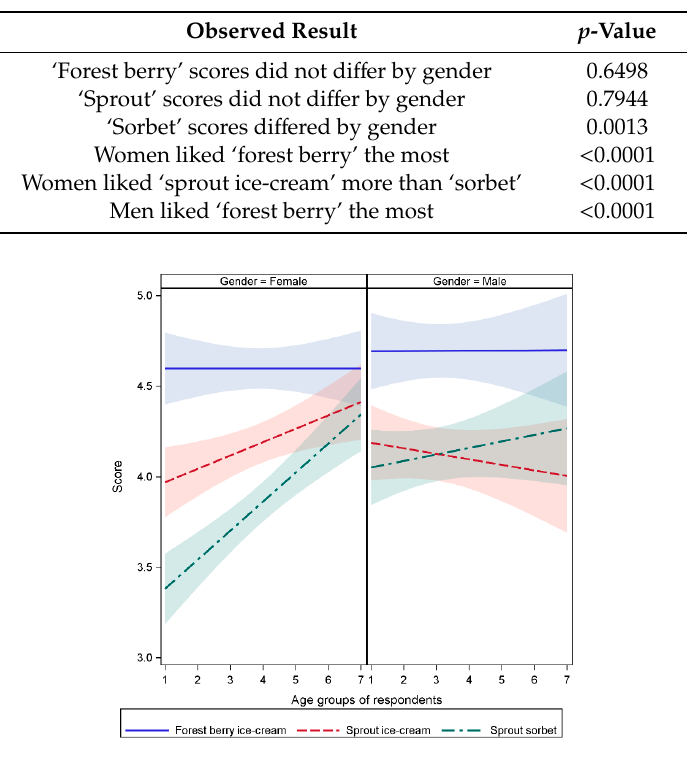
Figure 7. Di ff erences of sensory evaluation scores between gender and age groups of respondents. The evaluated products were cream-based ice-creams with forest berries (blue lines) and sprouts (red lines), and sorbet with sprouts (green lines). The numbers on the x-axis refer to the age groups of the respondents (years): 1, 0–6; 2, 7–13; 3, 14–17; 4, 18–24; 5, 25–40; 6, 41–60; 7, >60.